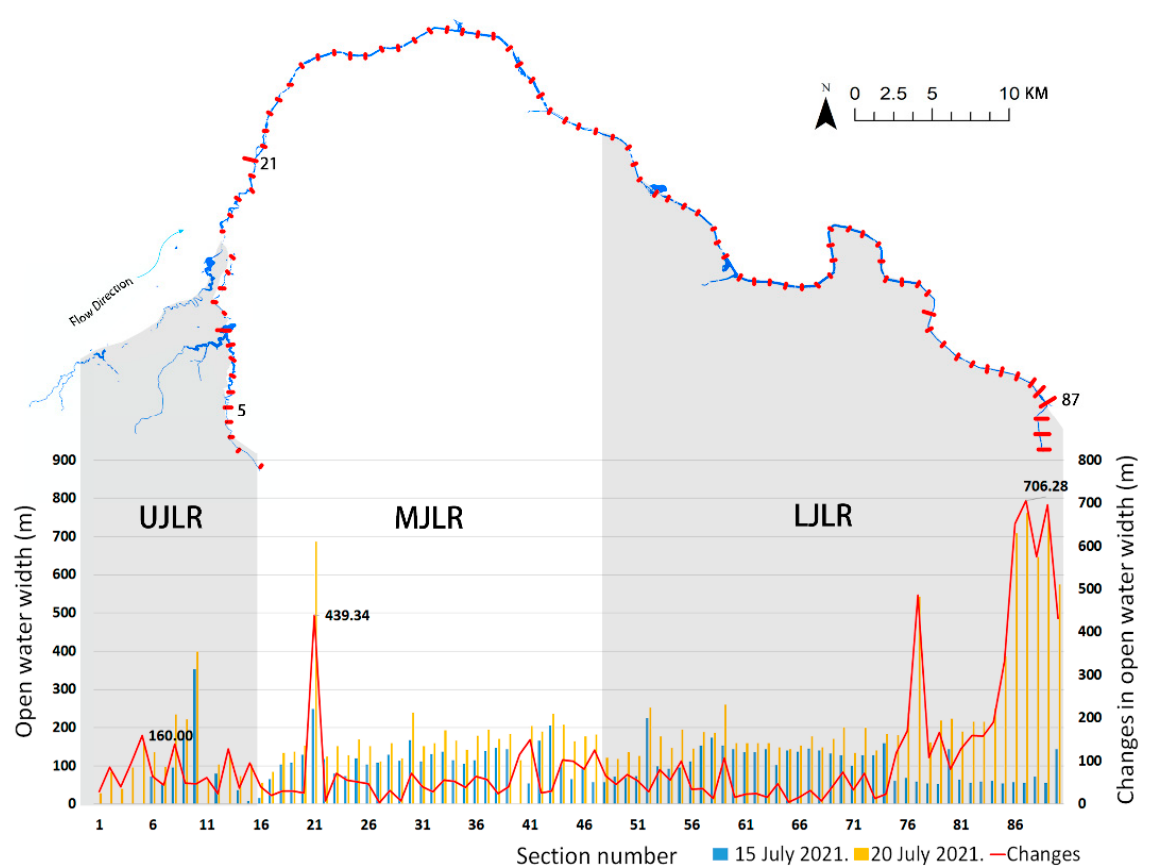
Figure 5. The three regions of the Jialu River from upper to lower, with discerned changes in open water extents from the pre- to post-flood scenarios across each of the transects taken within each region.